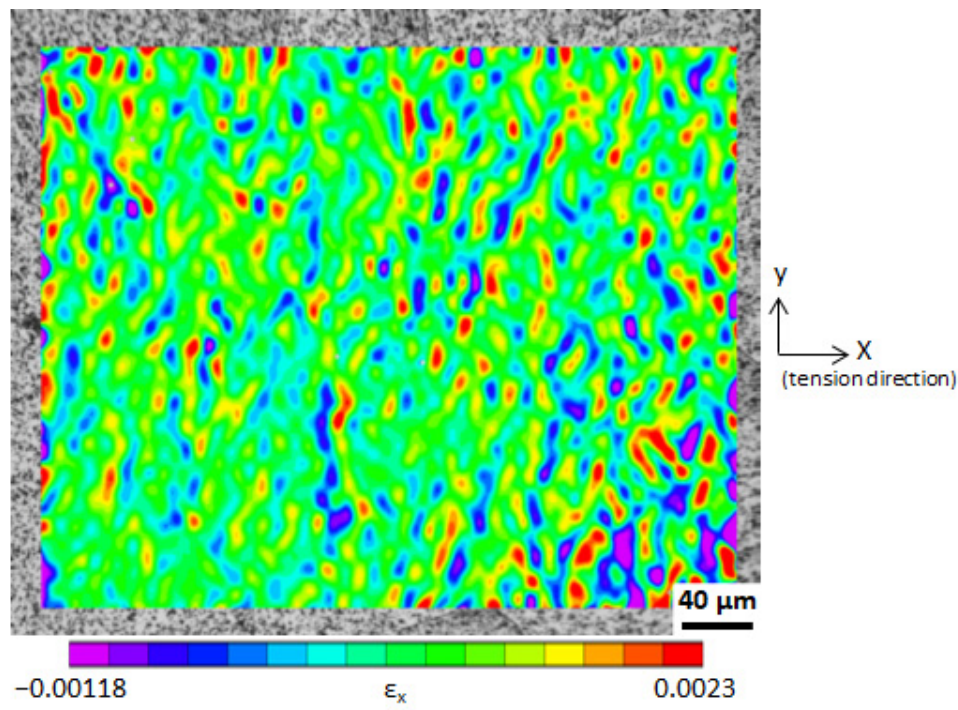
Figure 4. Two-dimensional longitudinal strain ( ε x ) field at an applied stress of 147 MPa.